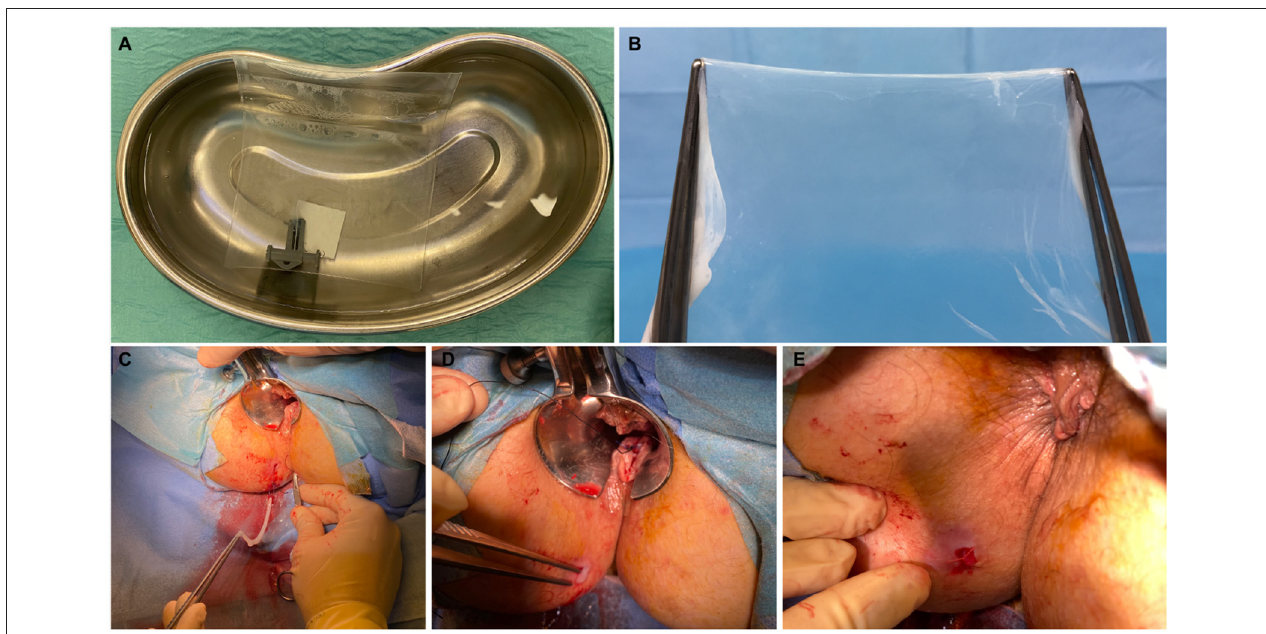
FIGURE 1 | Patient A—A 6 × 6cm human amniotic membrane (HAM) is defrosted and washed from the cryoprotective medium with hot saline (A) ; the HAM is removed from the envelope and prepared for implantation (B) . The HAM is hooked and pulled through the fistula tract (C) . Assessment of the correct placement of the HAM with its ends clearly visible at the level of the external and internal fistulous orifices (D) . HAM’s distal end fixed to the skin at the external orifice (E) .